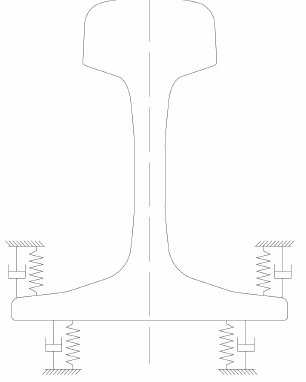
Figure 8. Fastener system